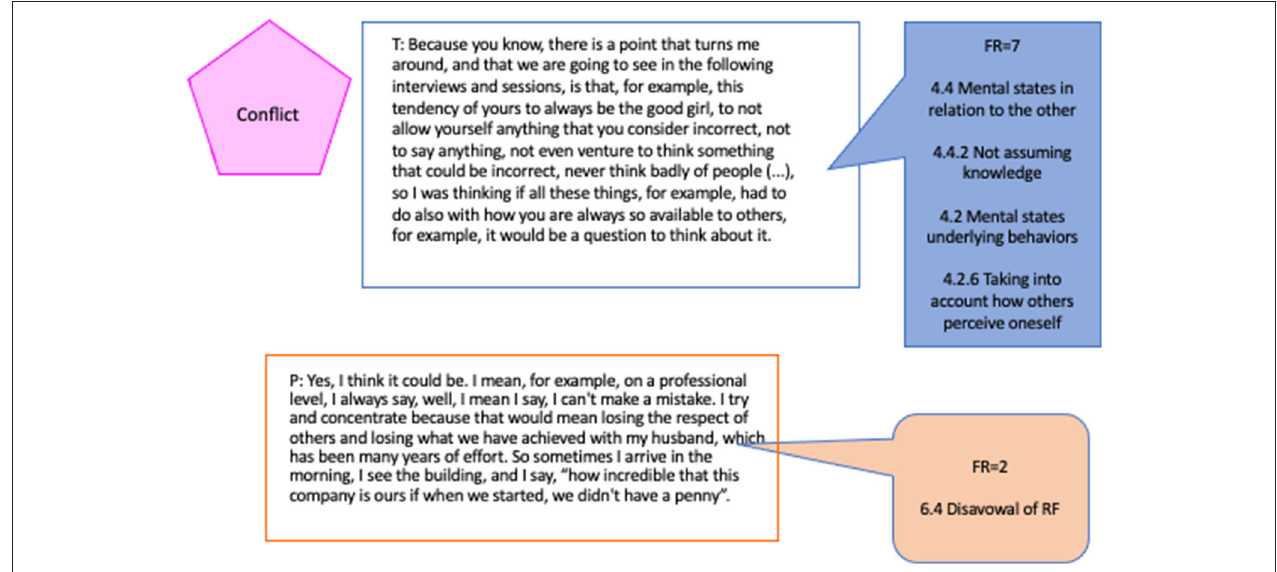
FIGURE 3 | Non-mentalizing interaction in conflict